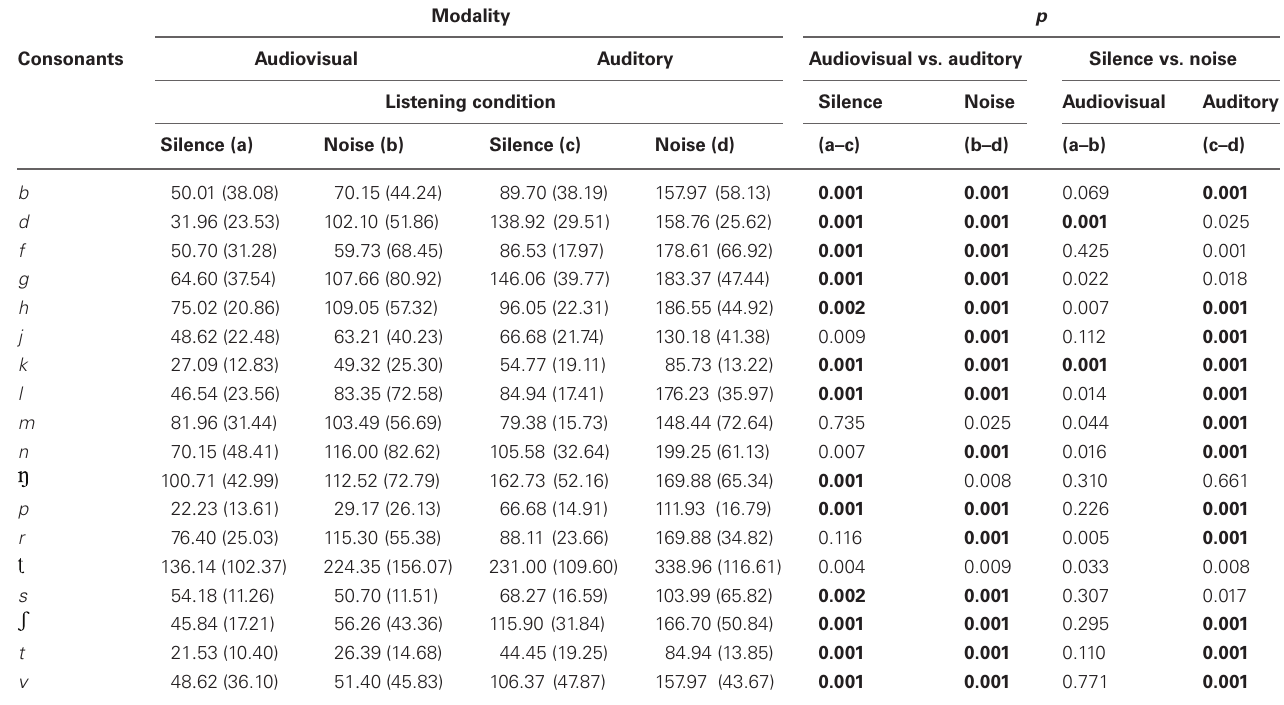
Table 4 | Mean IPs, SD (in parentheses), and significance levels for the identification of consonants presented audiovisually and auditorily in silence and